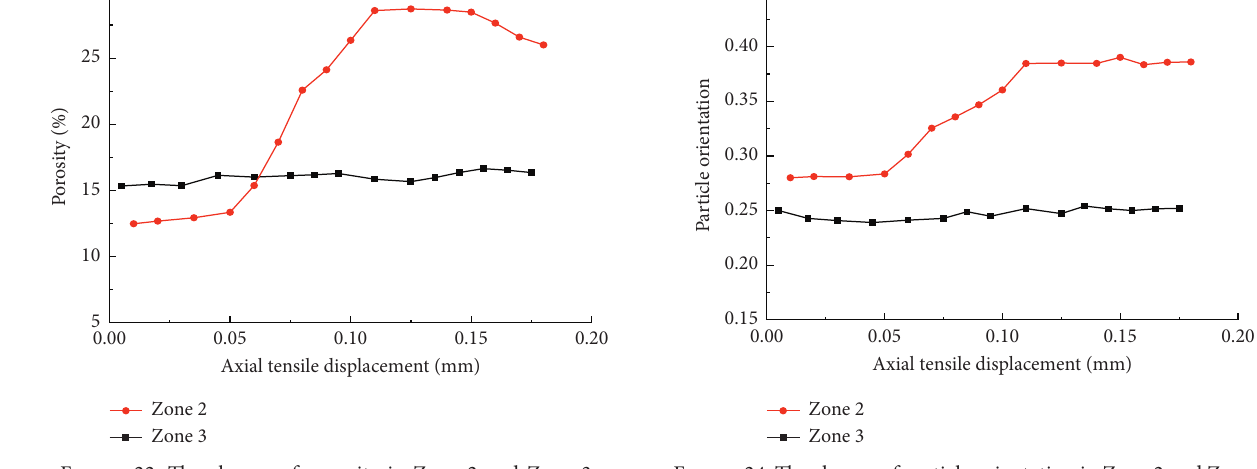
Figure 22: The change of porosity in Zone 2 and Zone 3.